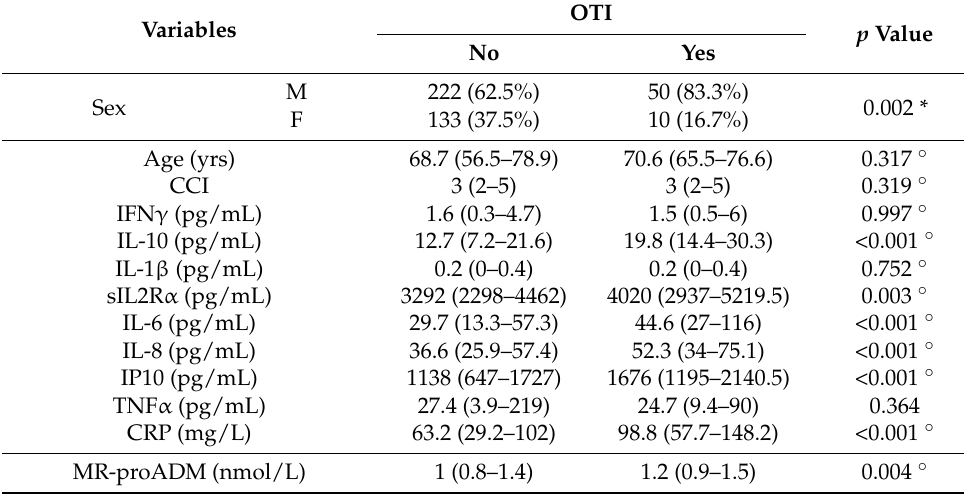
Table 3. Demographics, clinical and laboratory markers in OTI and non-OTI